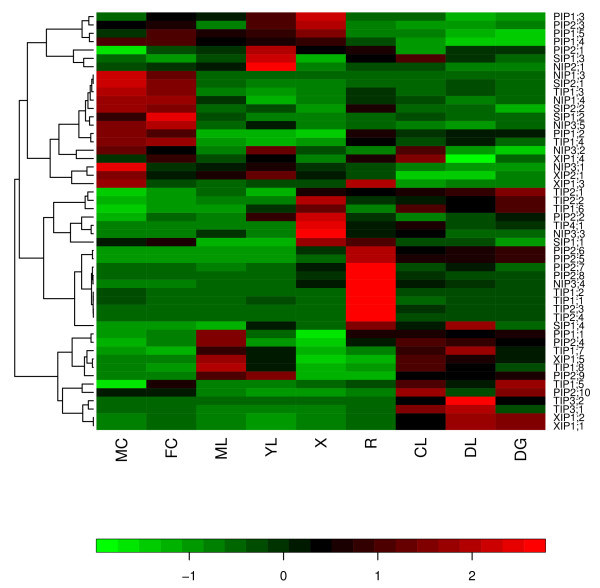
Relative transcript abundance profiles of Populus MIPs. A heat map showing the transcript abundance of MIPs from all Populus subfamilies [85] is displayed using the program "Heatplus" [86]. This heat map is produced using the expression data obtained from Populus eFP browser [103]. The transcript abundance levels for the Populus MIPs were clustered using hierarchical clustering based on Pearson correlation coefficients. Each row corresponds to the normalized expression profile of a particular gene and their names are shown. Data obtained for nine different tissues for each gene are represented in columns. Symbols in the map represent as follows: ML -- mature leaf; YL -- young leaf; R -- root; DG -- dark-grown seedlings, etiolated; DL -- dark grown seedling etiolated and then exposed to light for 3 hrs; CL -- continuous light-grown seedling; FC -- female catkins; MC -- male catkins; X -- xylem. The data is normalized for each gene (row-normalized). The relative transcript accumulation is represented in a color code with green and red showing respectively the lower and higher levels of transcript accumulation.